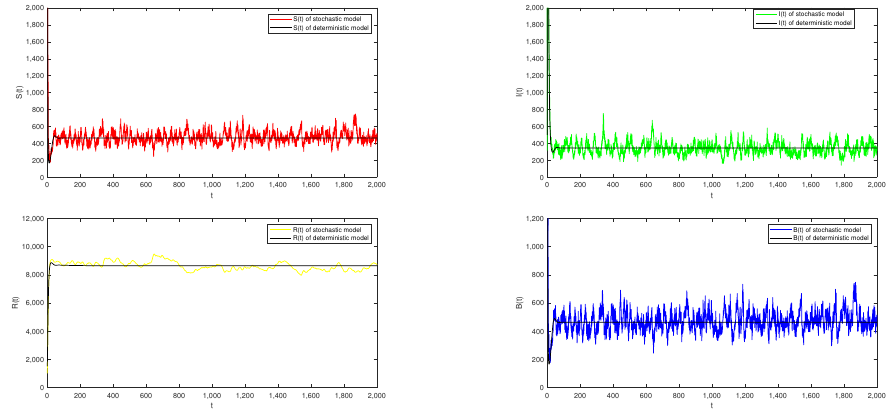
Figure 4. Paths of the deterministic model (1) and the corresponding stochastic model (2) with σ 1 = σ 2 =